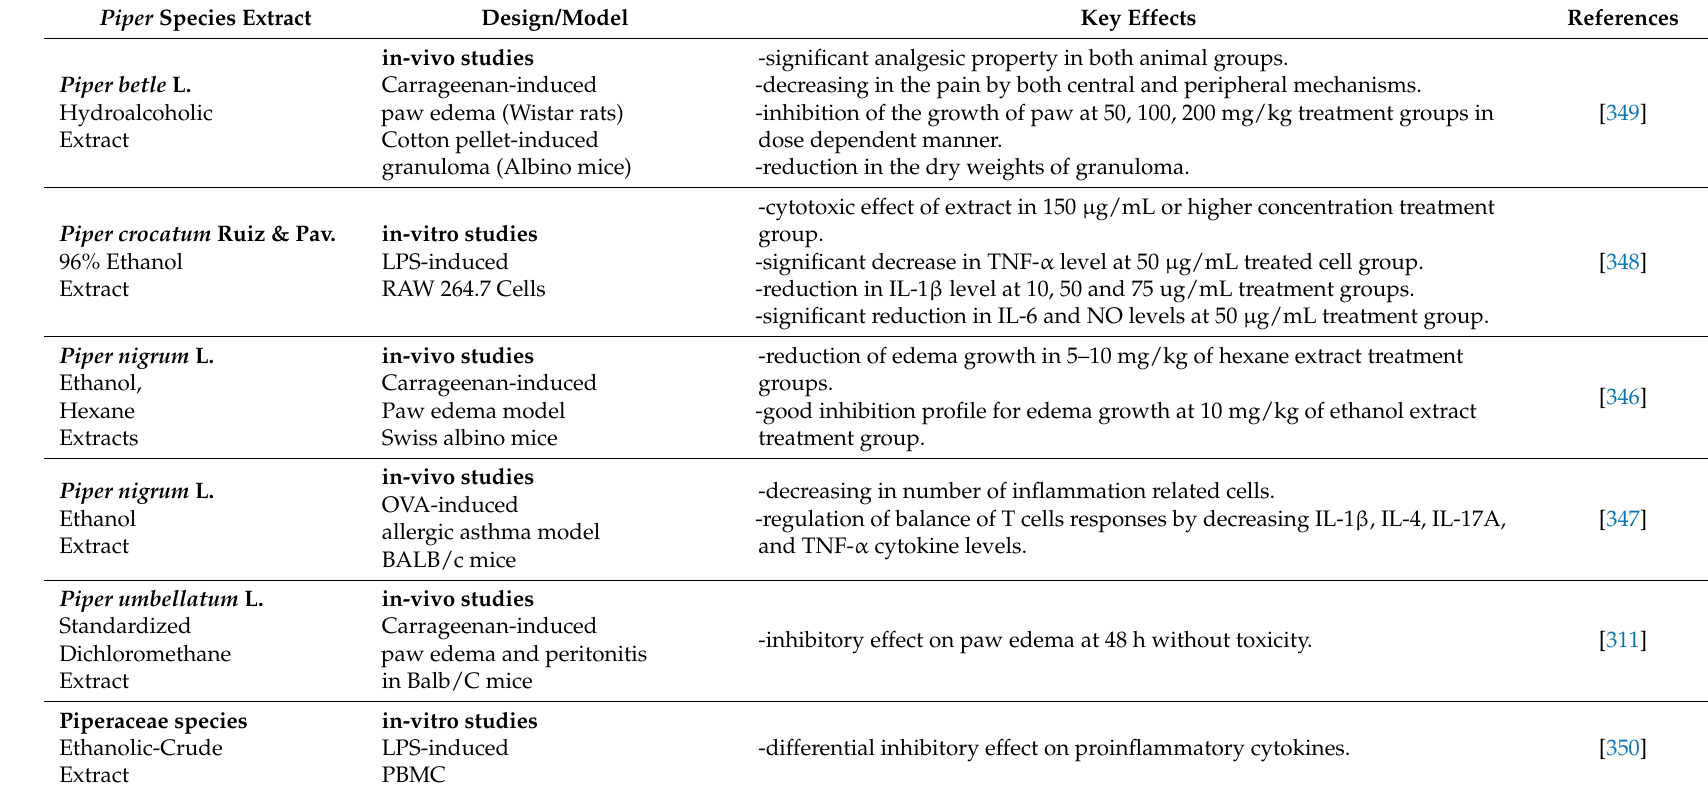
Table 31. Anti-inflammatory properties of different Piper